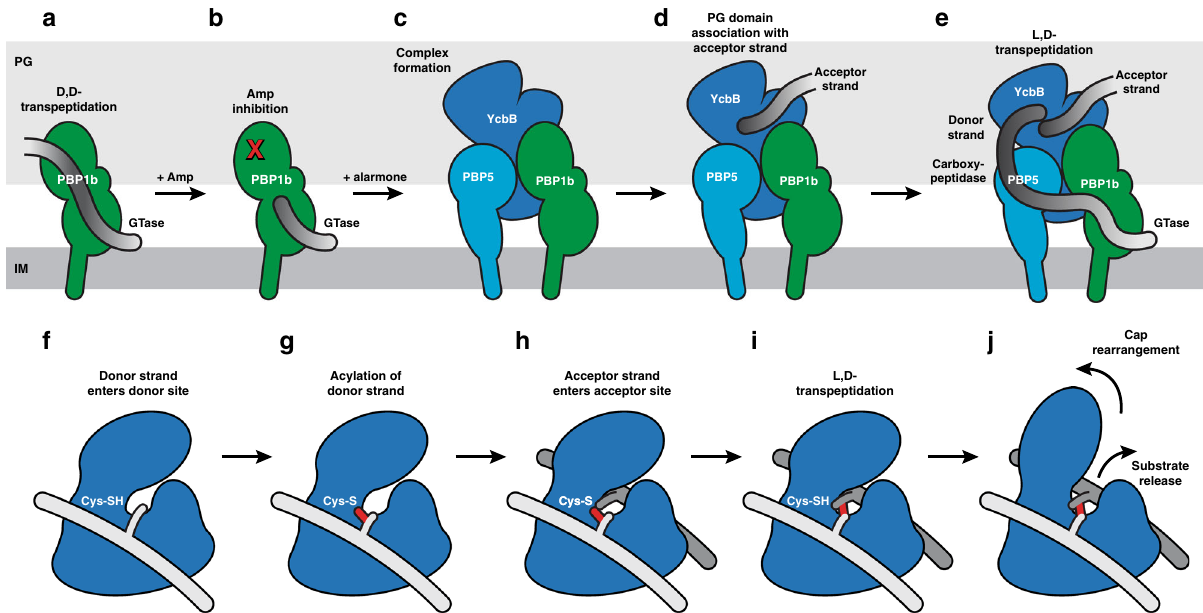
Fig. 6 Schematic representation of YcbB mediated beta-lactam resistance. a – e Assembly and function of the YcbB mediated beta-lactam resistance pathway. a PBP1b function in the absence of beta-lactam antibiotics. PBP1b acts as both glycosyltransferase and D,D-transpeptidase. b PBP1b function